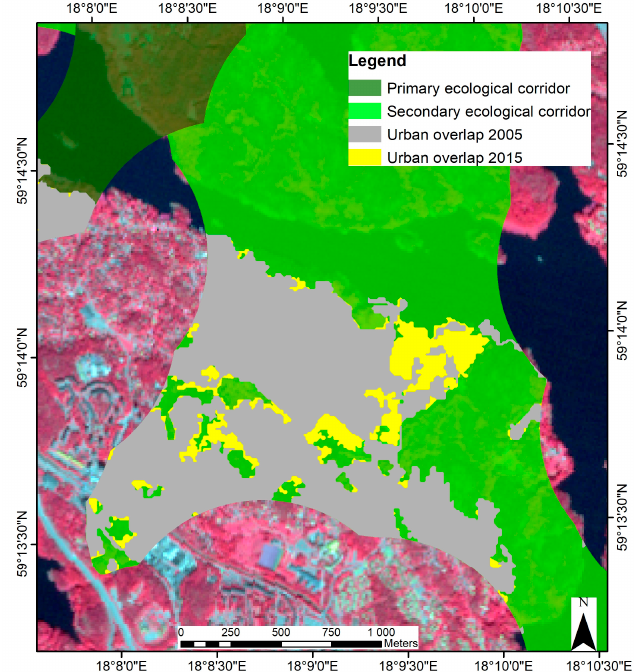
Figure 11. Urban overlap and expansion within the deciduous forest ecological corridor network in Trångsund in Huddinge Municipality between 2005 and 2015.